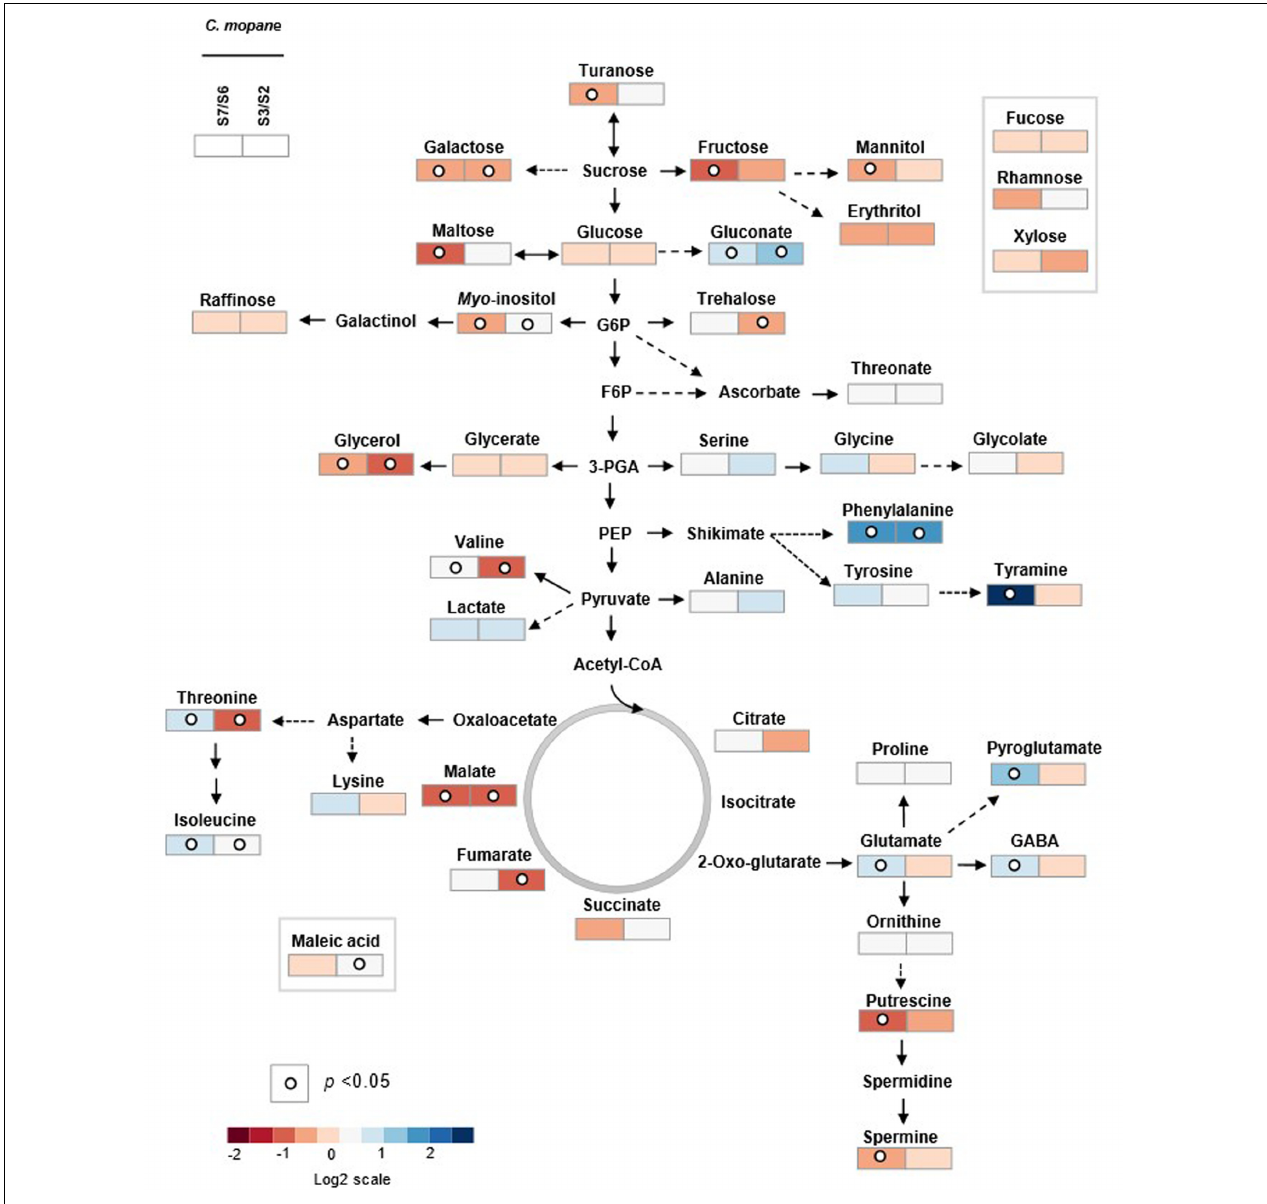
FIGURE 5 | Primary metabolic pathway reflecting the metabolite changes in C. mopane under different fire frequency regimes, low fire frequency (S6 and S2) and high fire frequency (S7 and S3). The relative values are represented by log2 of the ratio between S7/S6 ± SE and of the ratio between S3/S2 ± SE of ten accessions. Relative values are normalized to the internal standard (ribitol) and dry weight (DW) of the samples. Dots indicate that the differences are statistically significant by Student’s t- test ( p <